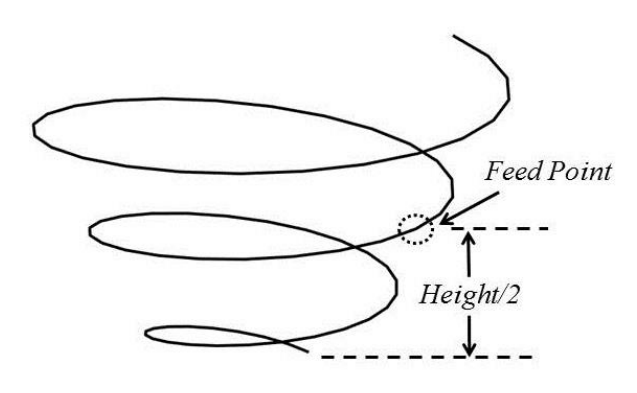
Figure 2: 3-Turn Conical Coil Illustrating Impedance Evaluation as Equivalent Electrically Small